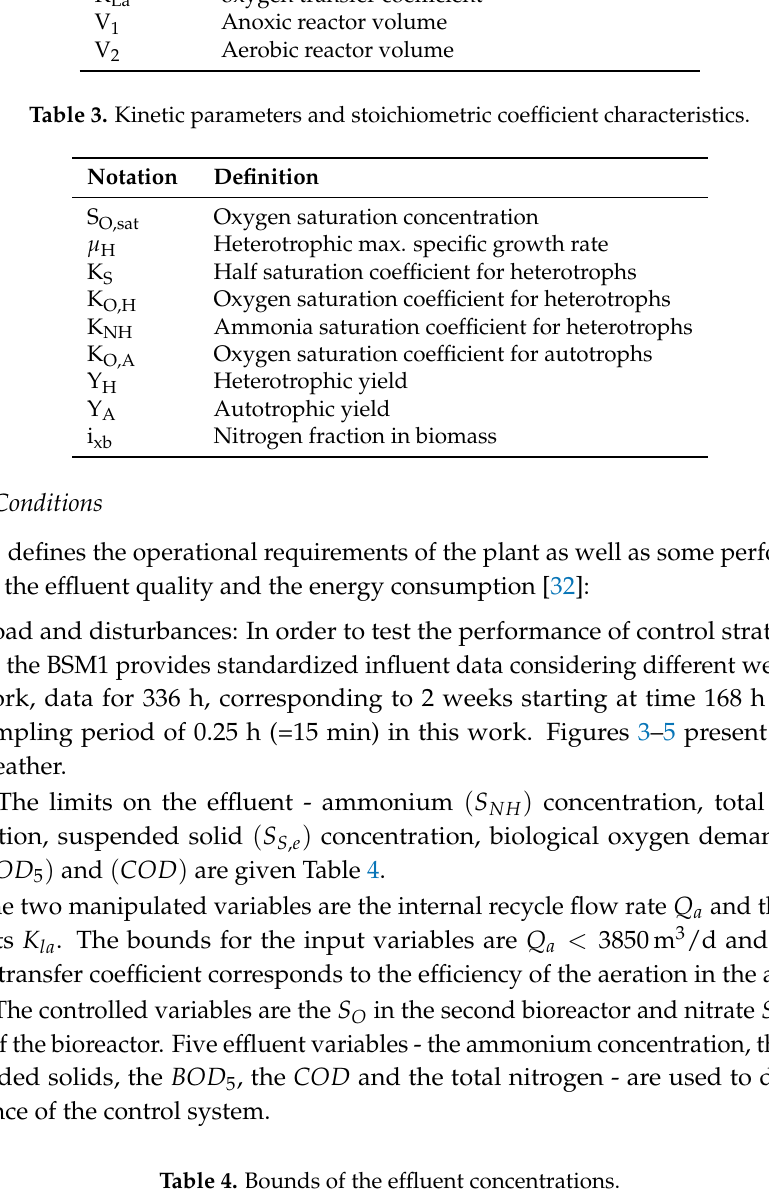
Table 4. Bounds of the effluent